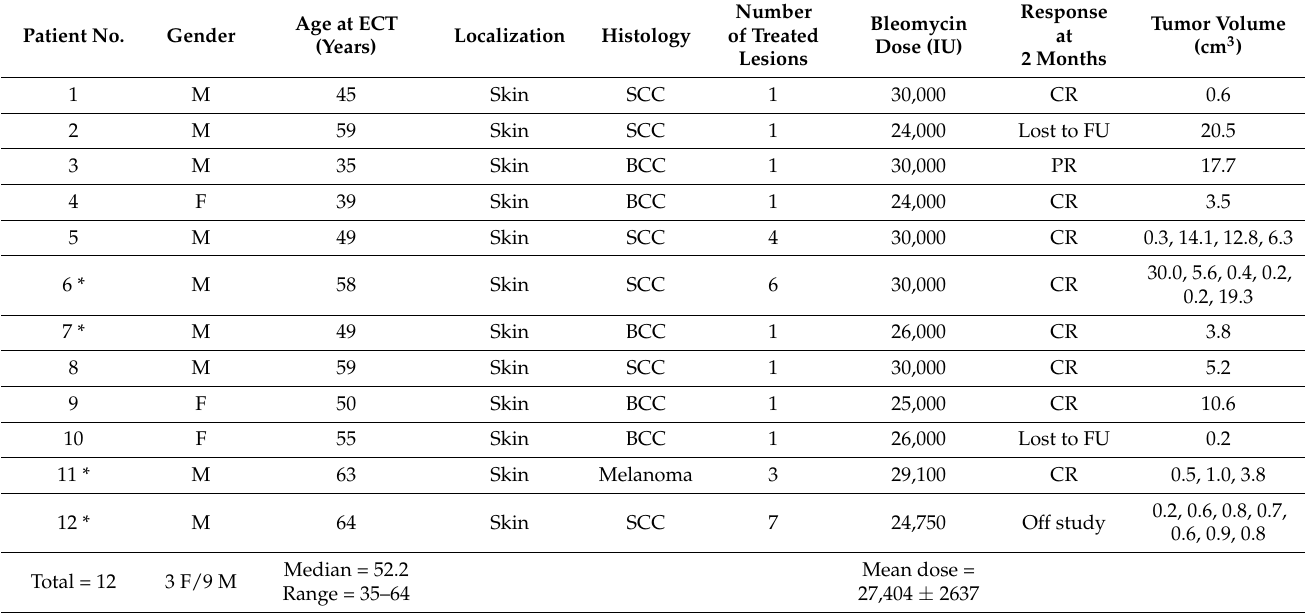
Table 1. Characteristics of patients eligible for blood collection, according to the tumor histotype, initial tumor volume, age and bleomycin dose given in treatment with electrochemotherapy and tumor response after 2 months according to RECIST 1.1 criteria.